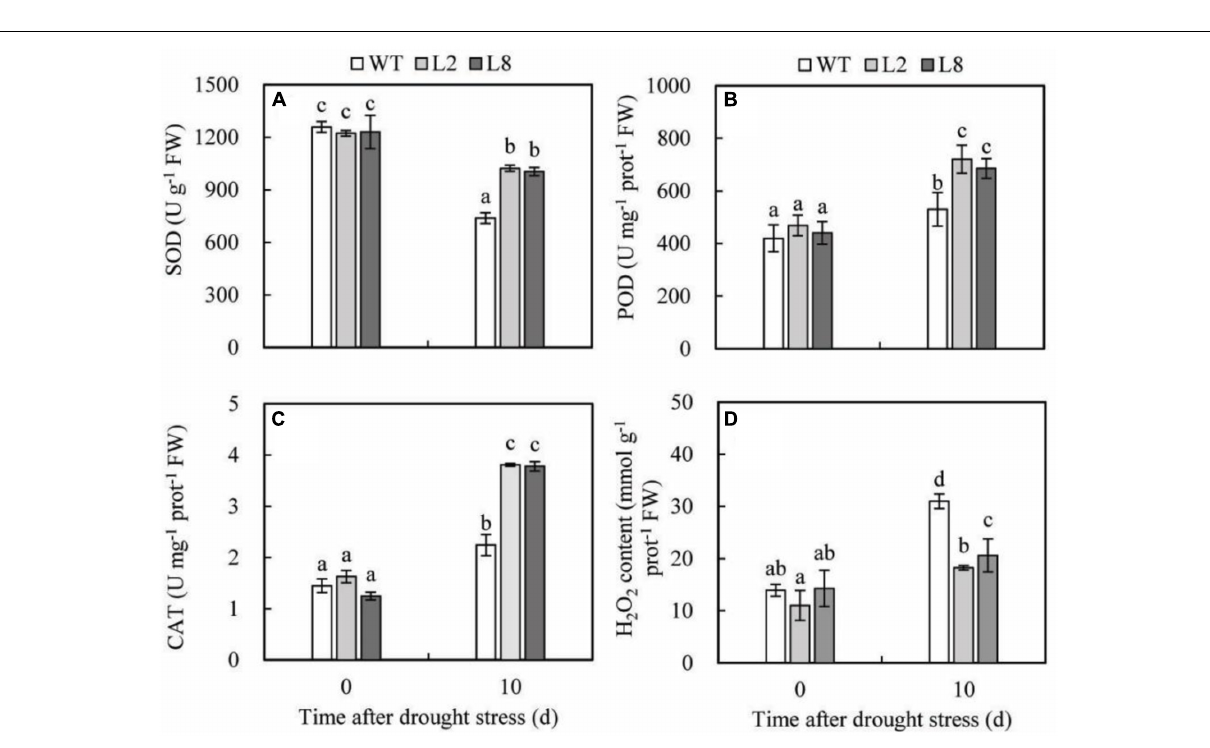
FIGURE 7 | Analysis of three antioxidant enzymes’ activities and H 2 O 2 accumulation in WT and transgenic lines (L2 and L8) under drought stress. Six-week-old seedlings were withheld water for 10 days to assess SOD (A) , POD (B) , CAT (C) , and H 2 O 2 (D) . Error bars represent SD and values with different letters are significant at P <